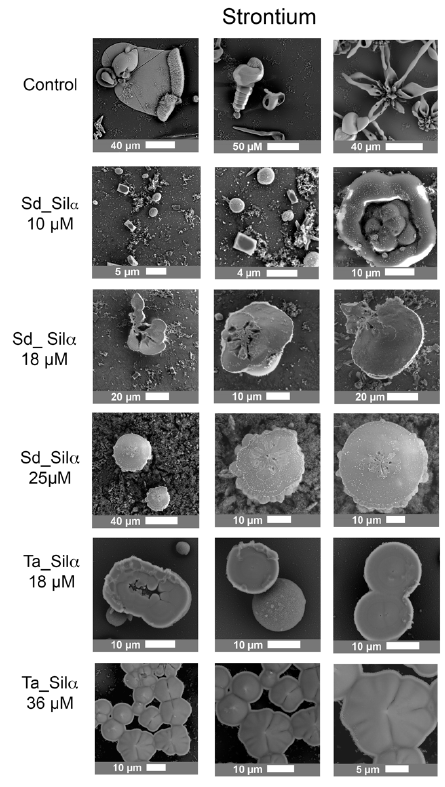
Figure 6. Selection of SEM micrographs from strontium silica carbonate biomorphs obtained at 25 ◦ C in the presence of different concentrations of silicatein- α . Sd_Sil α — Suberitis domuncula silicatein- α , Ta_Sil α — Tethya aurantia silicatein- α Raman spectroscopy was also used to elucidate the chemical composition of the silica carbonates of barium and strontium [46]. The Raman spectra of the control barium silica carbonate (Figure 7A) show the classical frequency between 1059 and 1061 cm −1 corre- sponding to BaCO 3 (I), identified as the aragonite-like crystalline structure usually called witherite. Other signals close to the reported bands at 227 and 690 cm −1 are also present. These same signals are present in the Raman spectra of barium silica carbonate biomorphs obtained in the presence of silicateins (Figure 7B–C), suggesting that the enzymes do not modify the crystal structure. On the other hand, the Raman spectra of control strontium silica carbonate biomorphs (Figure 8A) depict an intense band at 1068 cm −1 , which corre- sponds to the signal described between 1069 and 1075 cm −1 and that present at 855 cm −1 , characteristic of the strontianite. Similar vibrations are observed in the strontium bio- morphs obtained in the presence of silicateins (Figure 8B–C). In all, the presence of sili- cateins did not affect the crystalline structure of any of the alkaline metal carbonates but prevented the classical shape of barium and strontium silica carbonate biomorphs.